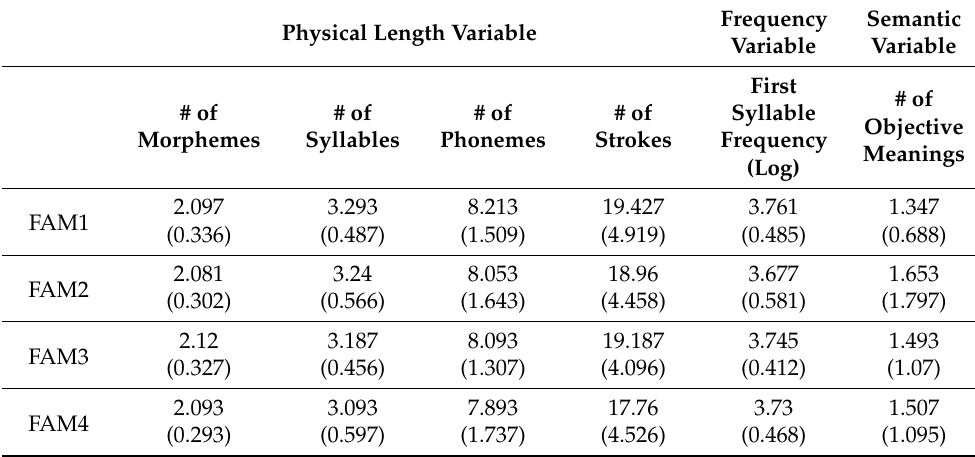
Table 1. The matched lexical variables between levels of word familiarity. The bracket values indicate standard deviations. Abbreviations: FAM1 (most unfamiliar), FAM2 (slight unfamiliar), FAM3 (slight familiar), and FAM4 (most familiar). Physical Length Variable